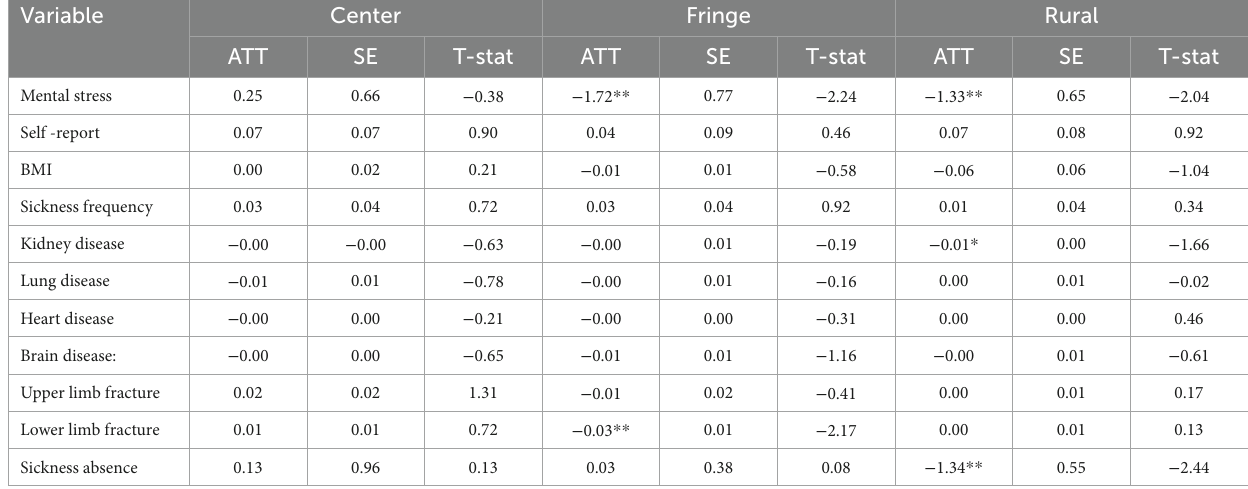
TABLE 7 Effects of bicycling on adolescent health in different